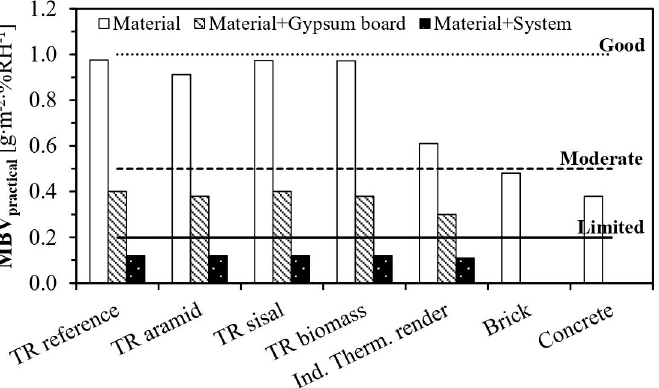
Figure 9. MBV practical when compared to other materials—Ind therm render [62], brick and concrete [59,77].